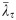
E. coli strains used in single-cell time-lapse measurements.A. F3/pTN001 strain. This strain expresses a fluorescent protein Venus-YFP and streptomycin resistance-conferring protein SmR under the control of the PLlacO-1 promoter from a low copy plasmid pTN001 (pSC101 ori). Ribosomal binding sites are present in front of the start codons of both structural genes, thus proteins are translated separately. We analyzed the data assuming that production rate and protein amount of SmR are strongly correlated with those of Venus-YFP. B. F3NW strain. This strain expresses a fusion protein Venus-SmR under the control of the PLlacO-1 promoter from intC locus on the chromosome. To facilitate the image analysis, we additionally integrated an mcherry-rfp gene that is expressed under the control of the PLtetO-1 promoter [33] from galK locus on the chromosome. C. MICs of streptomycin for F3, F3/pTN001, F3/pTN002, and F3NW. Absorbance at 595 nm of cell cultures of each strain at different concentrations of streptomycin was measured after 20-hour incubation with shaking at 37°C. pTN002 is a negative control plasmid in which the smR gene was removed from pTN001. The average of three replicates are plotted with the standard deviation for each condition of streptomycin concentration. We determined MICs by the minimum concentration above which the absorbance of cell culture remains below 0.1 (cyan region): 8 μg/mL for F3 (gray) and F3/pTN002 (purple), 250 μg/mL for F3NW (brown), and 1000 μg/mL for F3/pTN001 (green). D. Quantities obtained from time-lapse images. We extracted the time-series of cell volume v, protein concentration (mean fluorescence intensity per cell area) c, and total protein amount (sum of fluorescence intensity of the pixels within a cell) a = cv together with cell lineage trees, and calculated λ¯τ, p¯τ, and c¯τ for each cell lineage according to the definitions in Eqs 15–17.